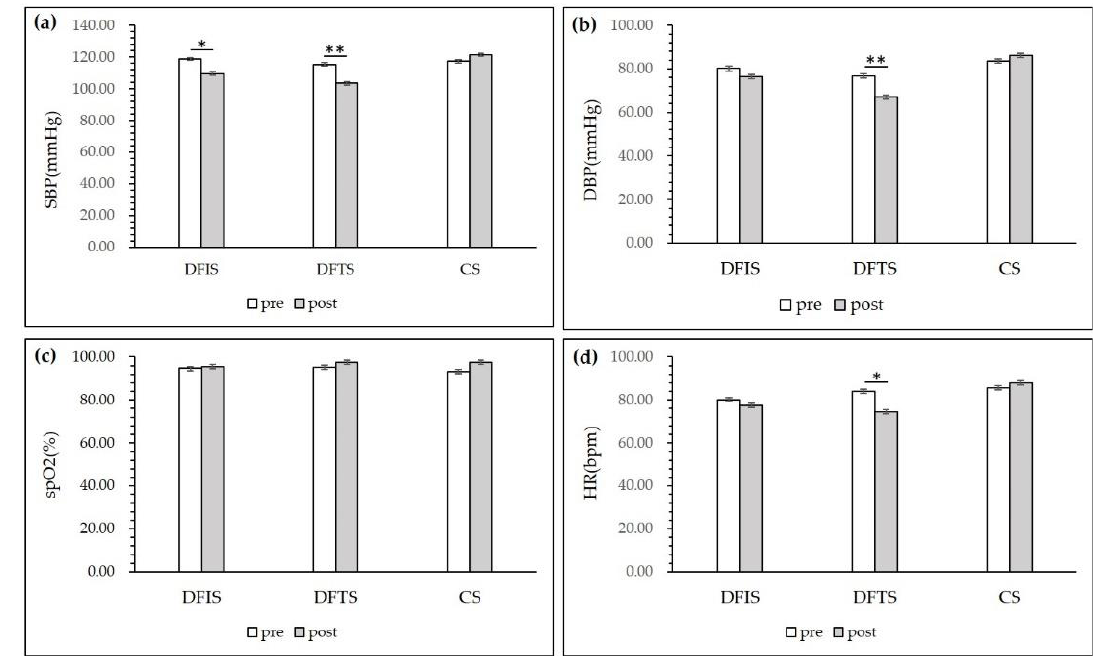
Figure 4. Systolic blood pressure, diastolic blood pressure, peripheral oxygen saturation, and heart rate of the participants after the experiment in the three stimulating environments: ( a ) Systolic blood pressure change; ( b ) Diastolic blood pressure; ( c ) Peripheral oxygen saturation change; ( d ) Heart rate change. ( n = 120; mean ± SD; * p < 0.05; ** p < 0.01; verified by a paired t-test, DFIS: deciduous forest interior setting; DFTS: deciduous forest trail setting; CS: city setting).